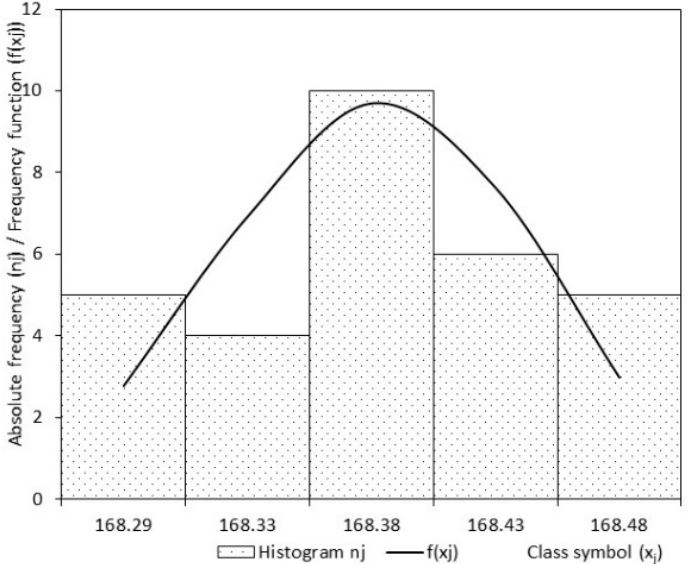
Figure 7. Histogram and the frequency function for the width parameter, second day.